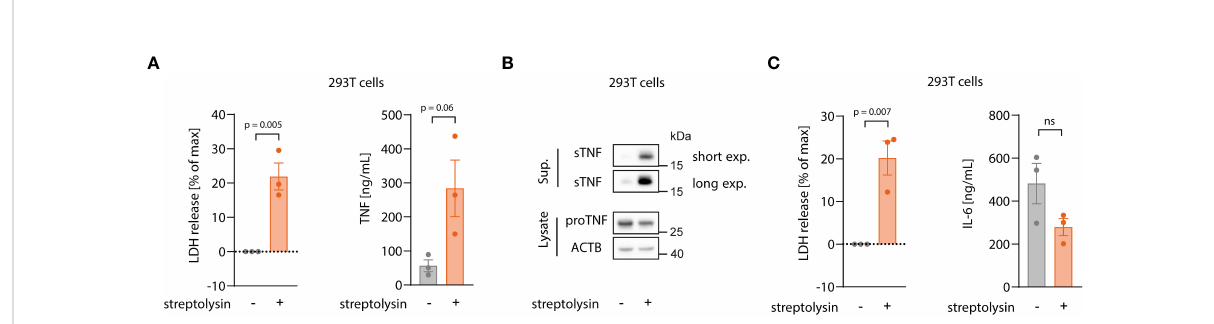
FIGURE 6 Enhanced TNF shedding is a general phenomenon of lytic cell death rather than a speci fi c necroptosis-related feature. (A, B) 293T cells were transfected with 100 ng/well of pRP_TNF in a 96 well format. After 18 h, medium was changed without or with streptolysin for 7 h Supernatant and cell lysates were collected for LDH, ELISA (A) and immunoblot (B) . (C) 293T cells were transfected with 100 ng/well of pRP_IL6 in a 96 well format and treated as in (A) . LDH release and IL-6 secretion were assessed in the supernatant. Data are depicted as mean ± SEM of three independent experiments. Statistics (A, C) indicate signi fi cance by an unpaired two-tailed t-test: P values as indicated or ns, not signi fi